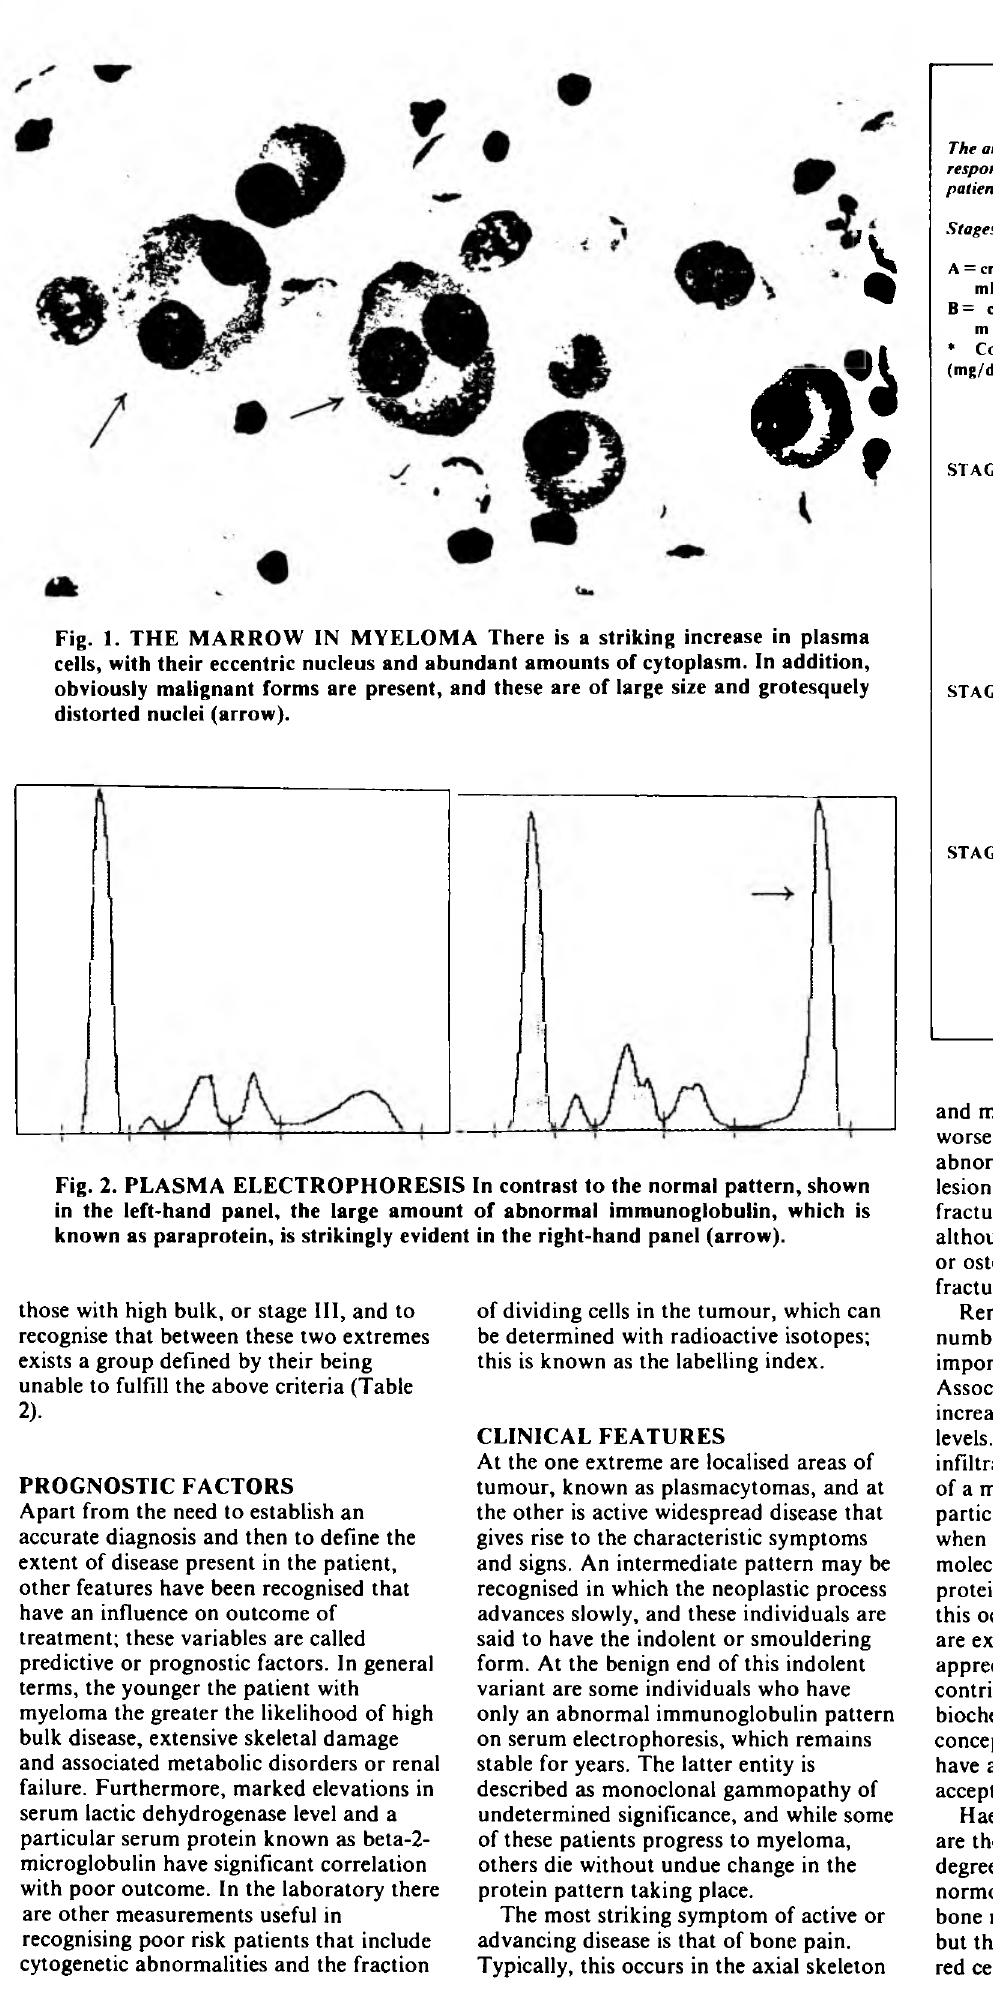
those with high bulk, or stage III, and to recognise that between these two extremes exists a group defined by their being unable to fulfill the above criteria (Table 2 ).